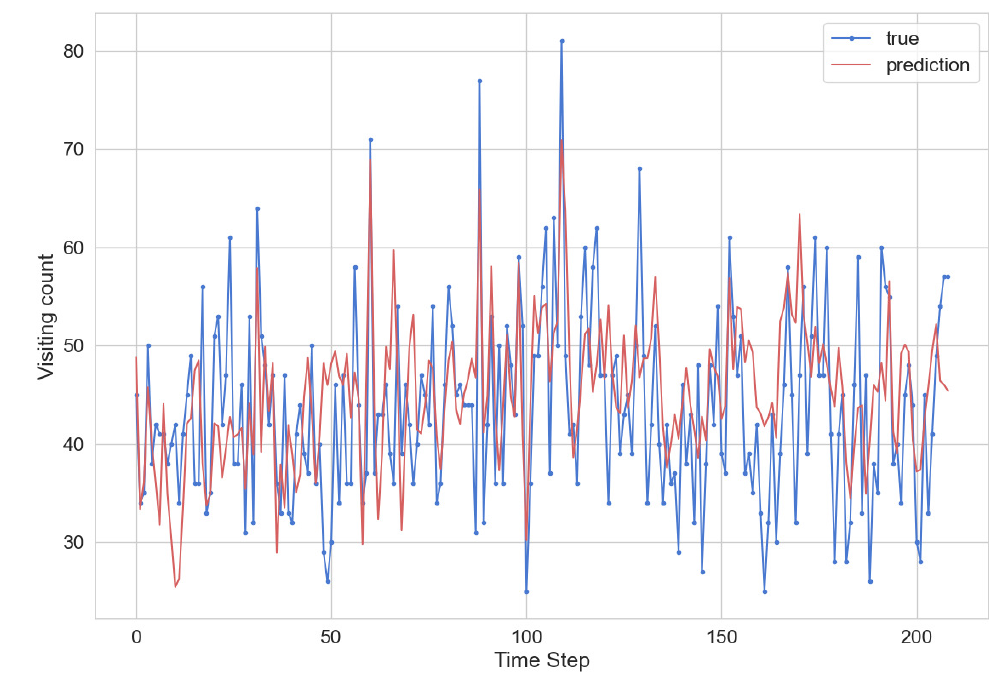
Figure 5. Attraction visiting prediction